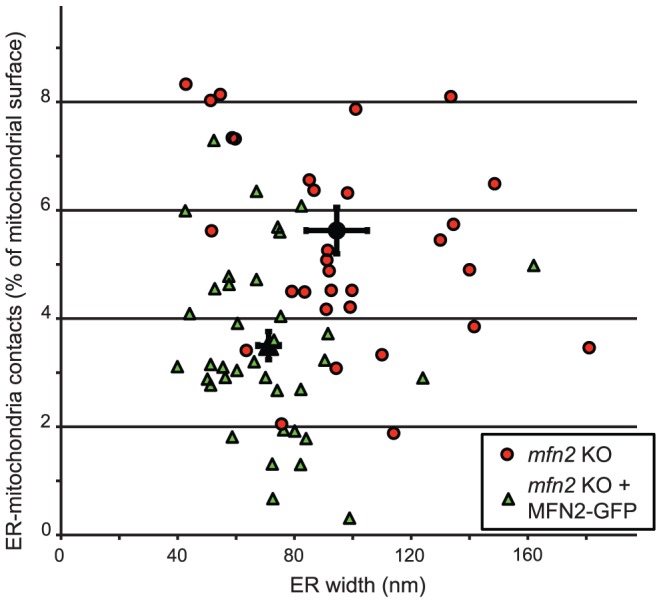
Complementation of mitofusin-2 KO cells.Mfn2 KO cells were transfected with a plasmid driving the expression of Mitofusin-2 fused to GFP. Cells expressing moderate levels of fluorescence were sorted, re-grown, fixed and processed as described in the legend to Fig. 1. For each individual cell profile, the frequency of ER-mitochondria tethering (expressed as % of the total mitochondrial perimeter) was determined, as well as the average width of ER cisternae. Mock-transfected mfn2 KO cells (red circles) exhibited wider ER cisternae and more ER-mitochondria tethering than cells re-expressing Mitofusin-2 (green triangles). For each population of cells, the average and S.E.M. are indicated in black.